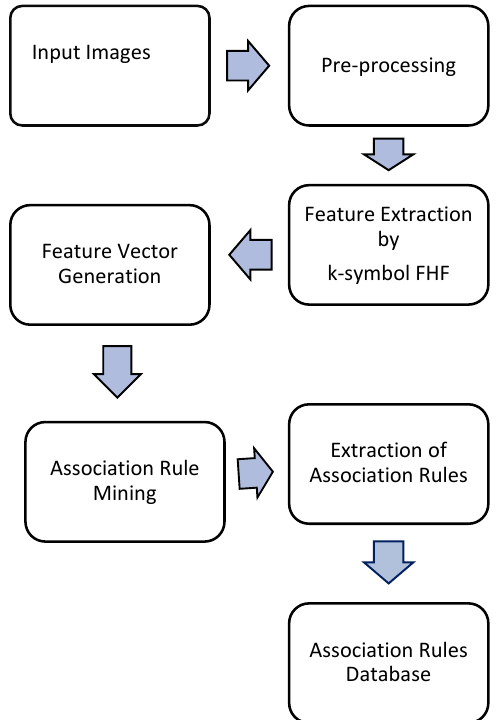
Figure 1. The steps for the proposed DIS in the training phase.